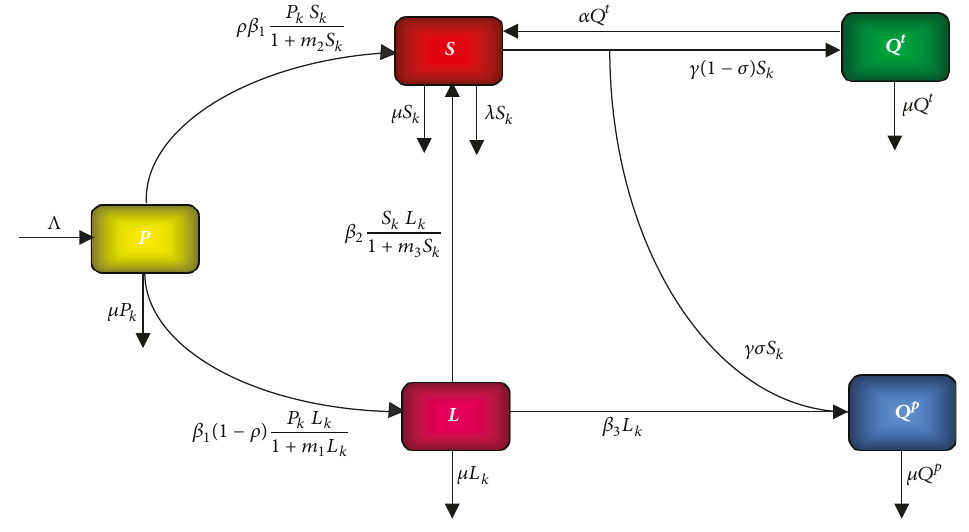
Figure 1: The flow between the five compartments 𝑃𝐿𝑆𝑄 𝑡 𝑄 𝑝